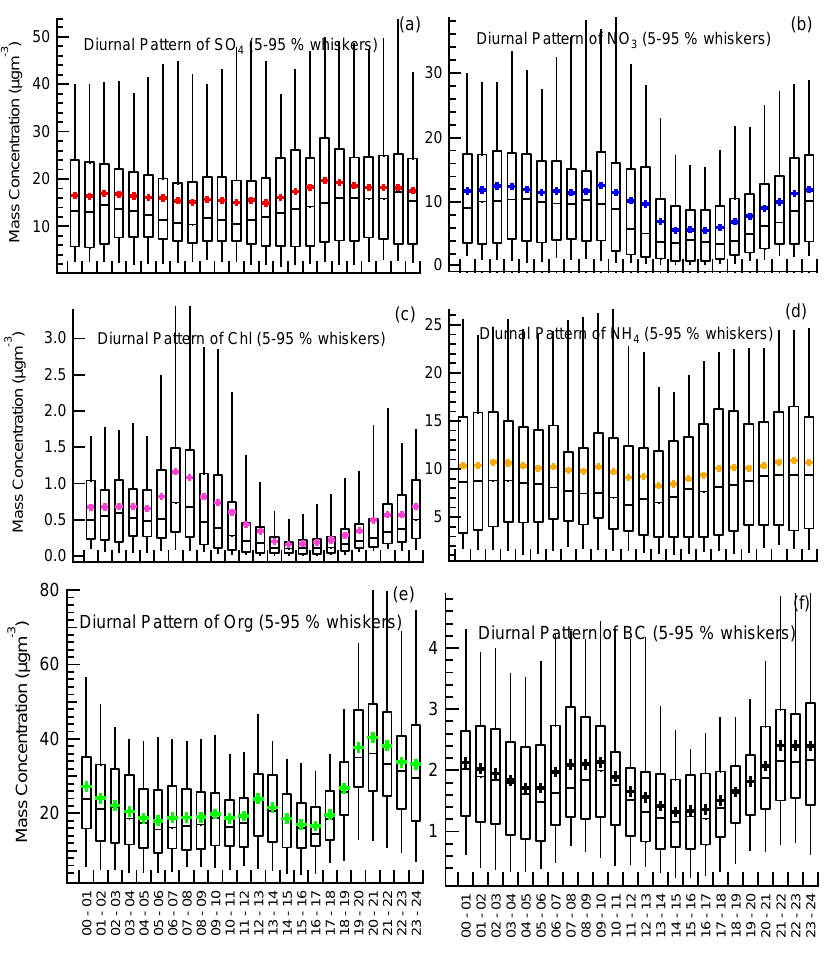
Fig. 2. Diurnal variation box plots of PM 1 species. The upper and lower boundaries of boxes indicate the 75th and 25th percentiles; the line within the box marks the median; the whiskers above and below boxes indicate the 90th and 10th percentiles; and cross symbols represent the means.